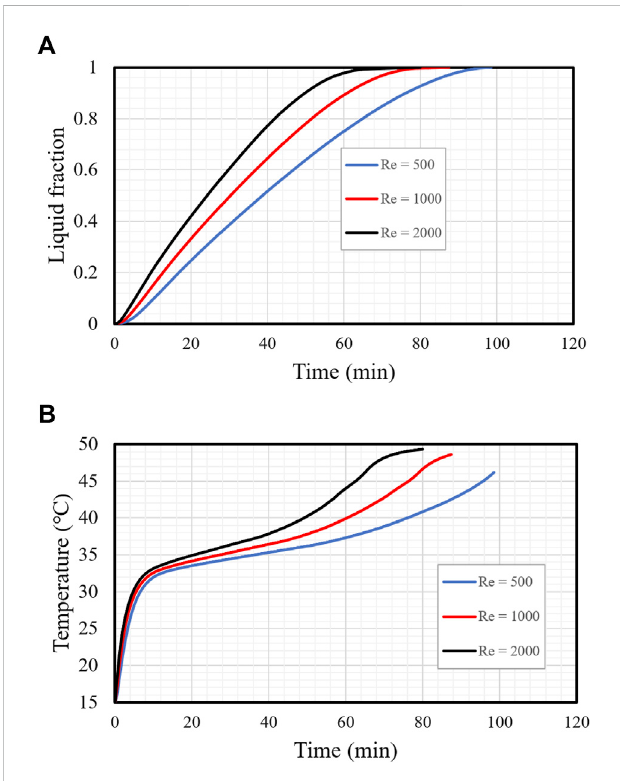
FIGURE 13 (A,B) Liquid fraction (A) and mean temperature (B) of the PCM with different Reynolds numbers (Re) during the charging